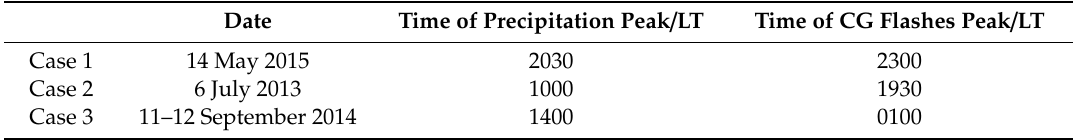
Figure 9. The vertical profiles of liquid water content (LWC) ( a ), vapor density (VD) ( b ), relative humidity (RH) ( c ), and temperature (T)( d ) in the precipitation peak and CG flashes peak of Case 1. (p represents the peak pf precipitation at the time of 2030 LT; -L represents the maximum number of CG flashes at the 2300 LT on 14 May 2015).